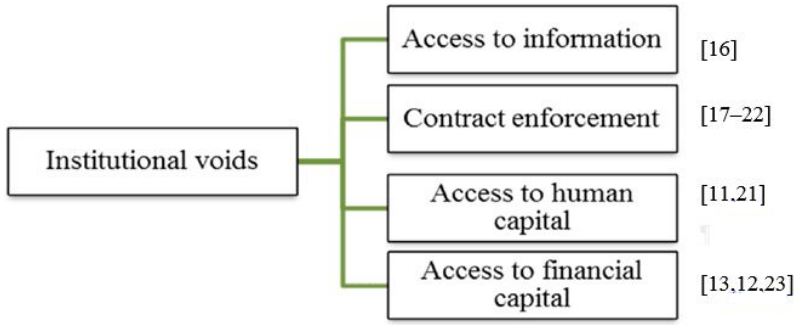
Figure 2 . Literature overview: Types of institutional voids (source: own